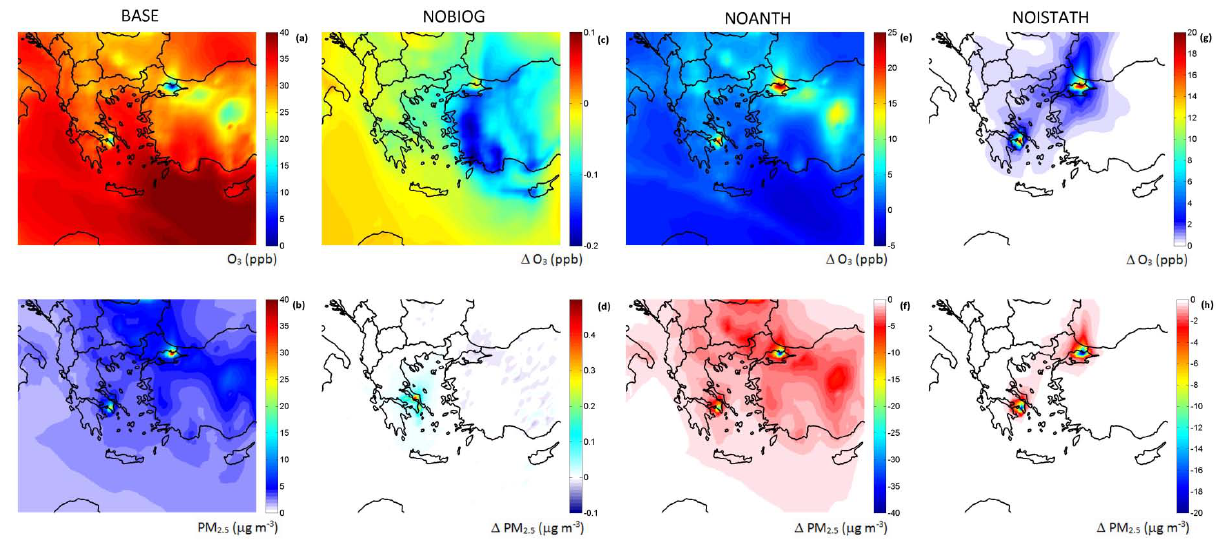
Fig. 2. Wintertime (December 2008) surface O 3 (a, c, e, g) and PM 2 . 5 (b, d, f, h) levels calculated from the base case scenario (Base: a, b ) and the absolute differences of scenarios “NoBiog” (c, d) , “NoAnth” (e, f) and “NoIstAth” (g, h) from the “Base”, averaged for the month of the simulation. Units areppbv for O 3 and 1 O 3 and µgm − 3 for PM 2 . 5 and 1 PM 2 . 5 .